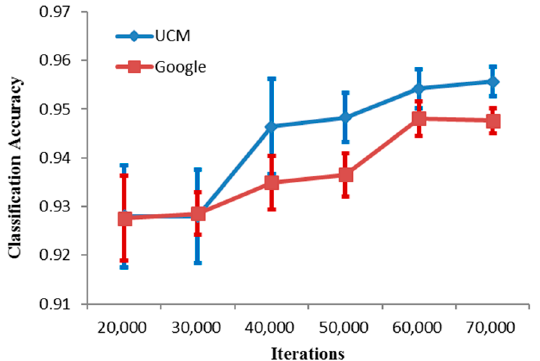
Figure 17. The overall accuracy of the SRSCNN on the UCM and Google dataset of SIRI-WHU with different iterations.